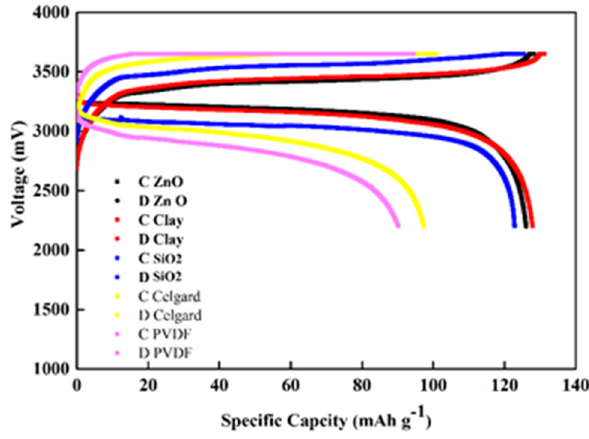
Figure 5: The charge – discharge pro fi les of LiFePO 4 /GPE/graphite with current densities at a charge rate of 0.2 C and discharge rate of 0.2 C.